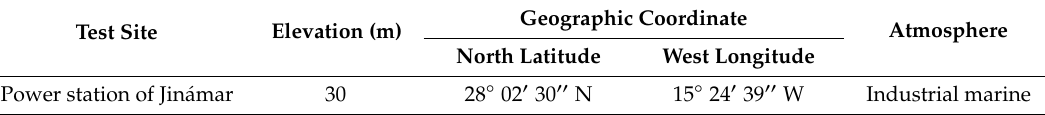
Table 1. Location and characteristic environment type of the test